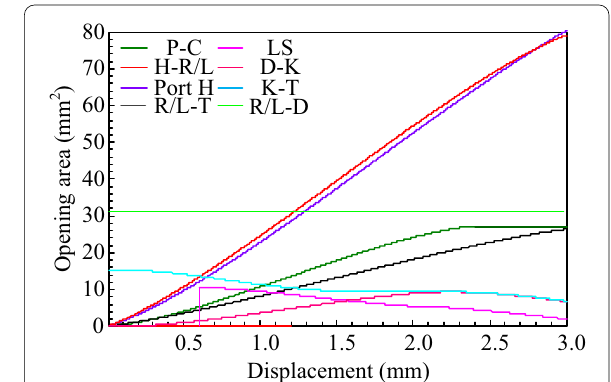
Figure 3 Relation between the opening area of each module and the control spool displacement